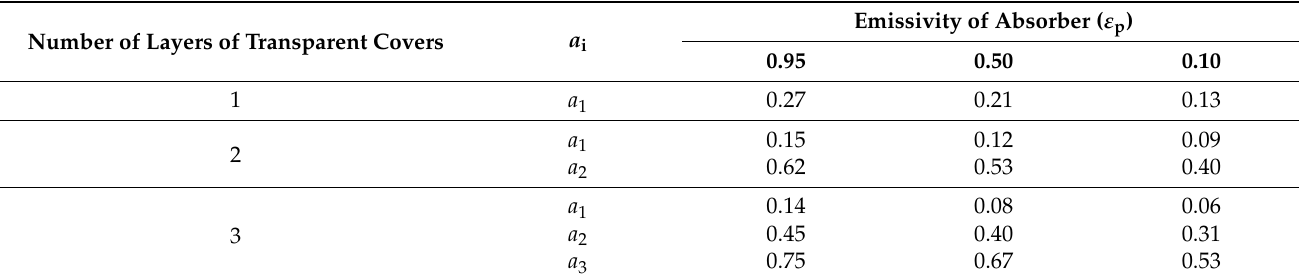
Table 1. The values of α i .